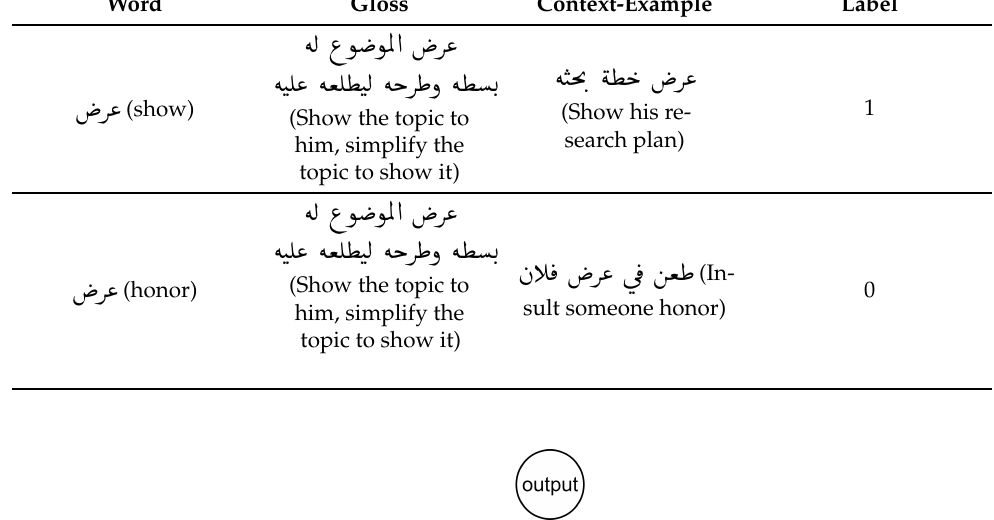
Table 4. The training data for Model I.